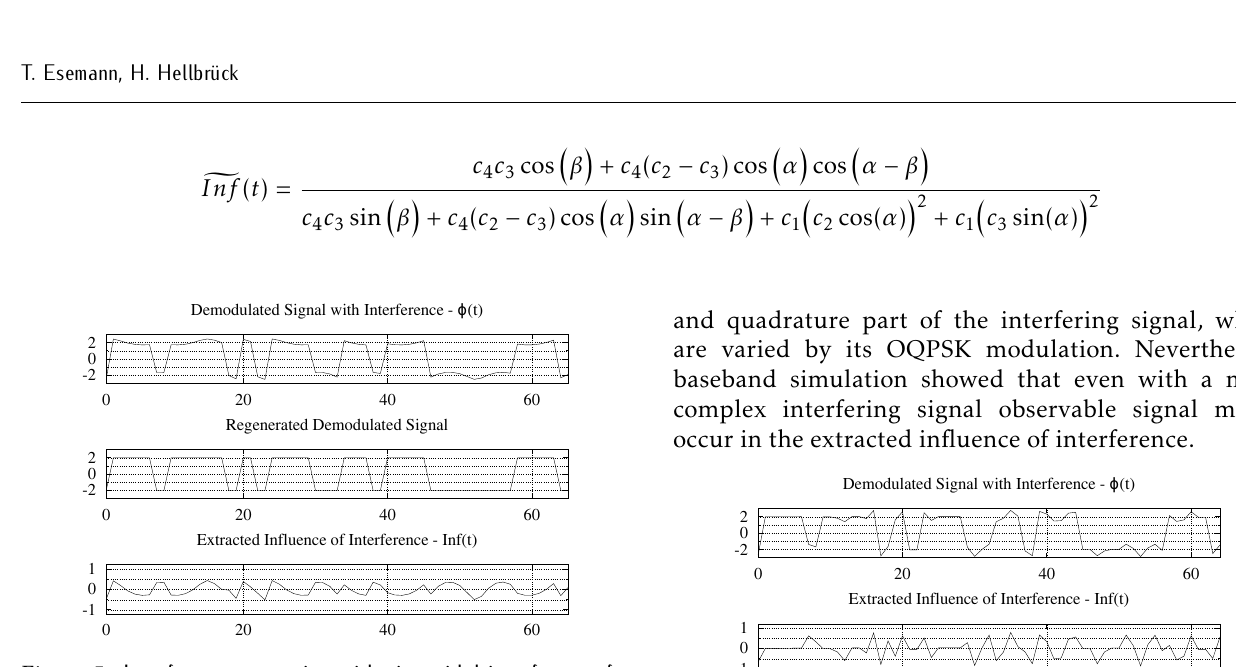
Figure 5. Interference extraction with sinusoidal interference for